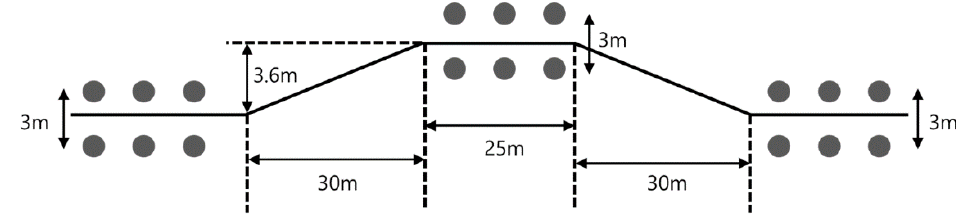
Figure 5. Double lane-change scenario.